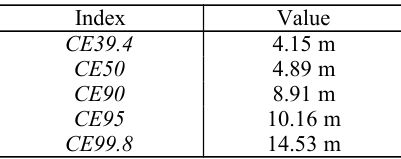
Table 3. Measures of error confidence areas for the probability values suggested by ISO (2013a)